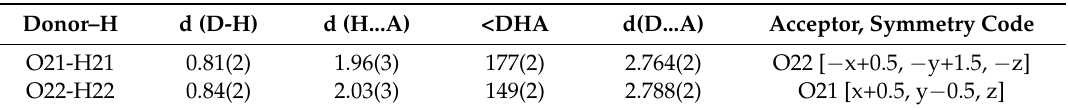
Table 3. Hydrogen bond geometry (Å, °).